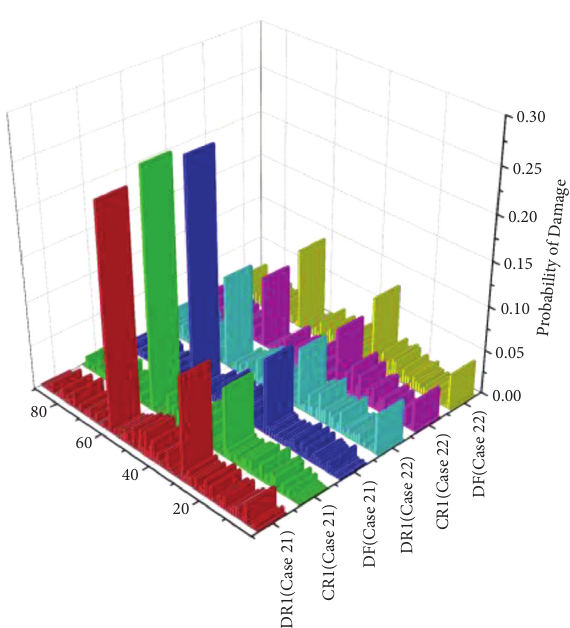
Figure 25: Recognition results for continuous girder of multilevel